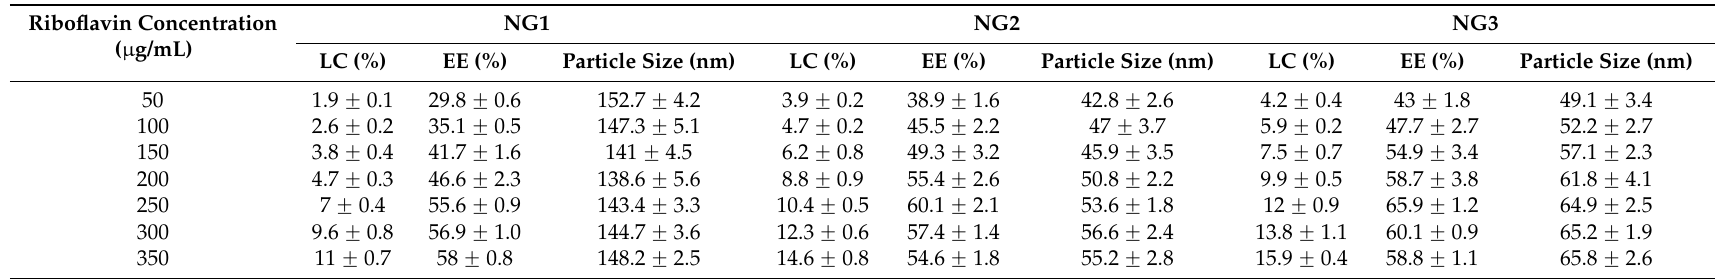
Table 2. Drug encapsulations, loaded efficiencies and particle sizes of the NGs in different riboflavin concentrations; the results are displayed as the mean ˘ standard deviation ( n =